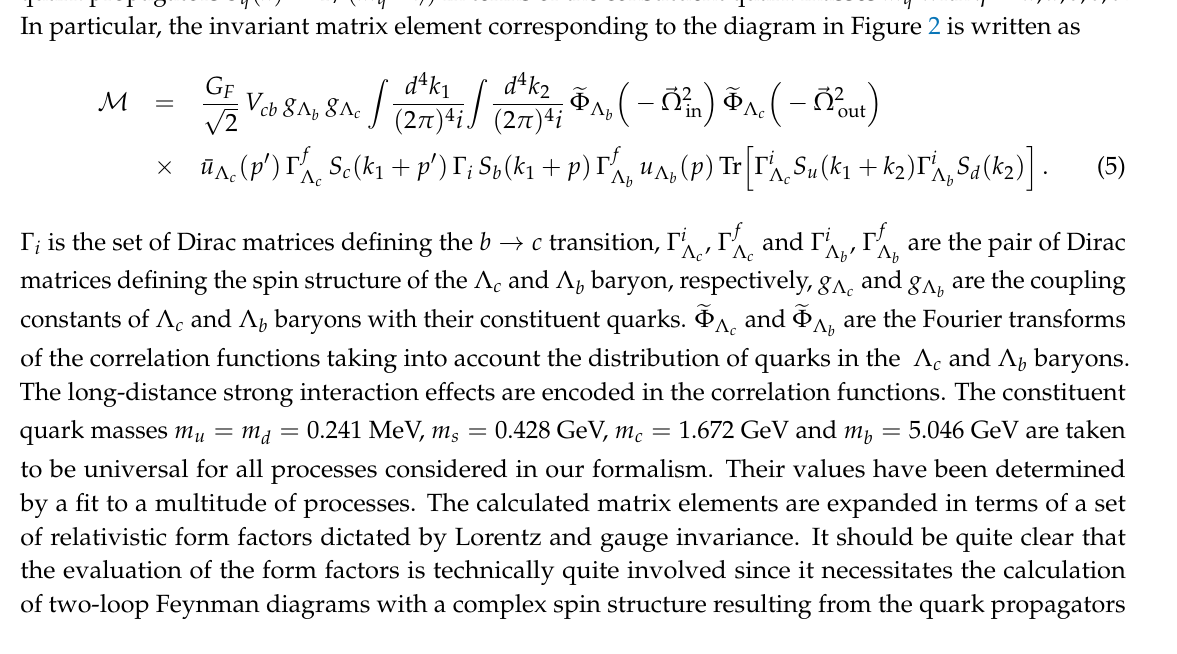
→ Λ + (cid:96) − ¯ ν (cid:96) c b